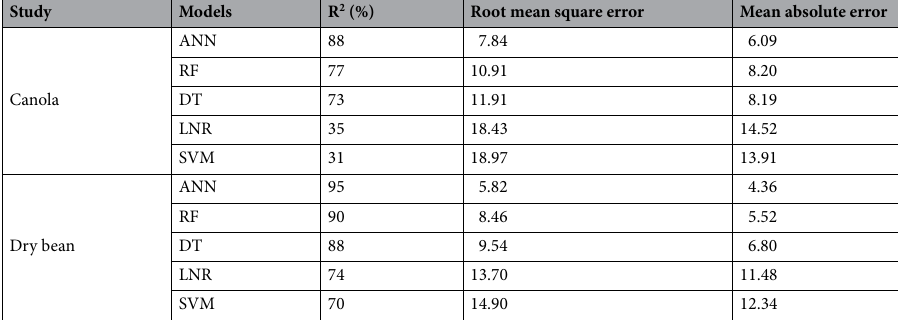
Table 4. Statistical fitness metrics of artificial neural networks (ANN), support-vector machine (SVM), random forest (RF), decision trees (DT), and linear regression (LNR) machine-learning models used in regression analyses of canola and dry bean data sets that associated incubation temperatures and duration of leaf wetness conditions to incidence of Sclerotinia stem rot disease.